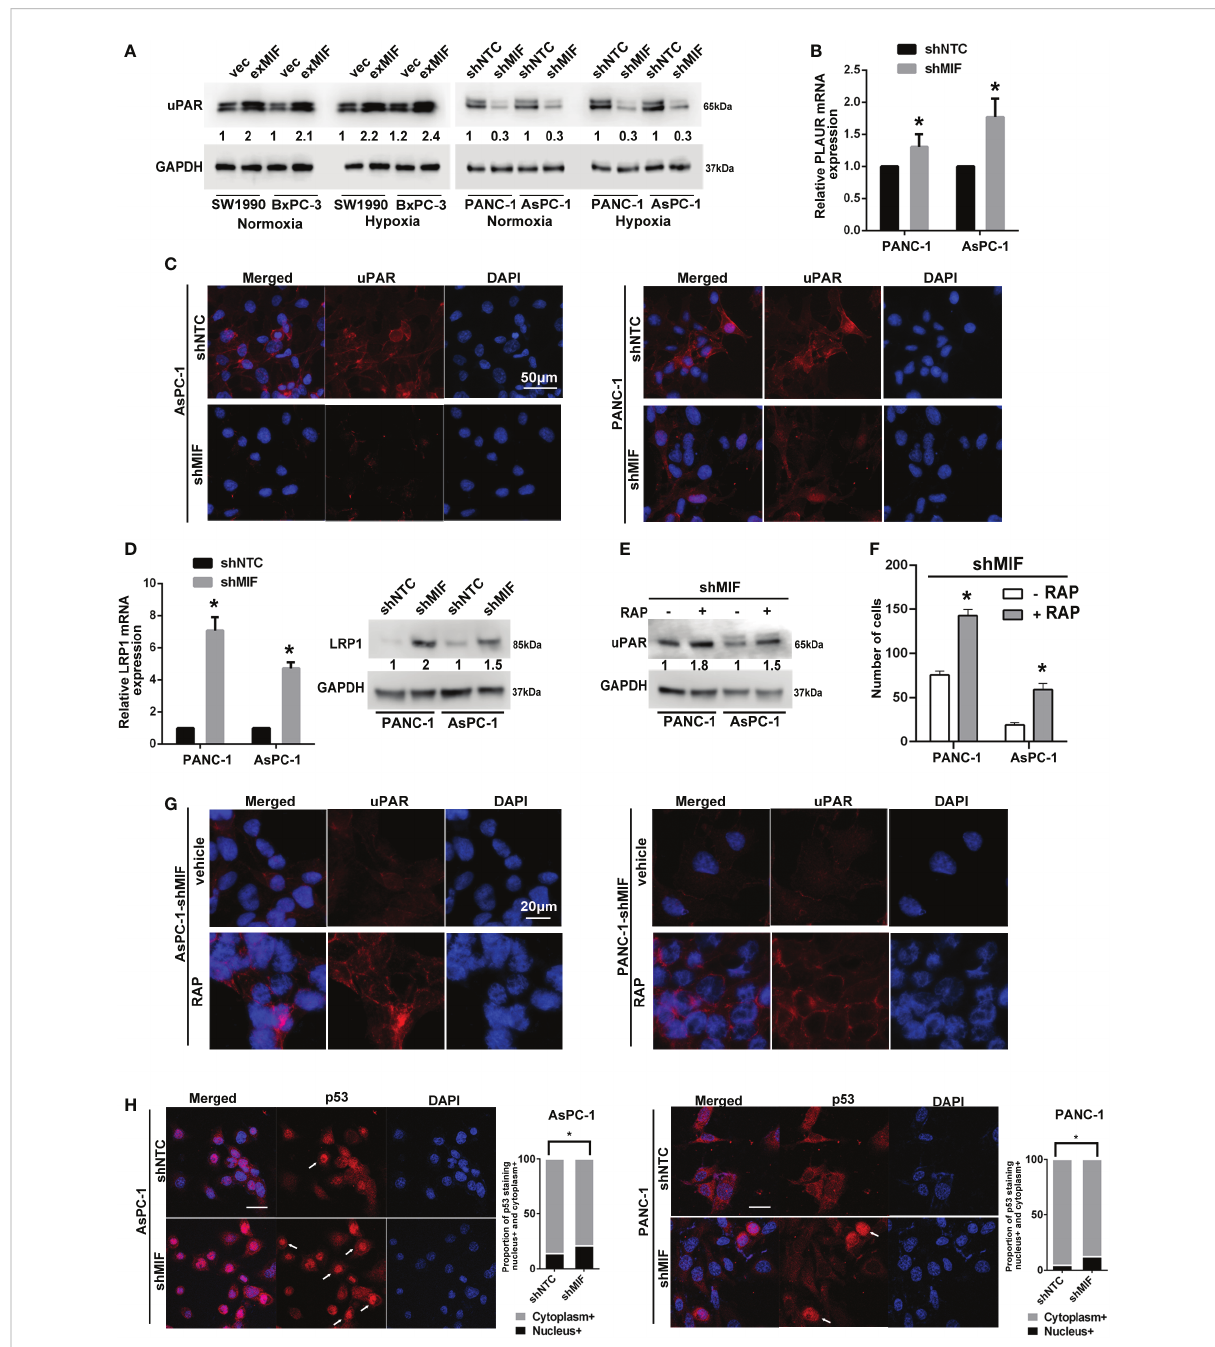
FIGURE 5 MIF enhances the expression of uPAR via LRP1 (A) Western blot analysis of uPAR in stably transduced PDAC cell lines after treatment with CoCl 2 or vehicle for 24 h. The numbers below the blots are quantitative ratios of the uPAR/GAPDH band densities. (B) Real-time PCR analysis using speci fi c primers for PLAUR with pancreatic cancer cell lines. (C) Confocal microscopy images of shMIF cells for uPAR expression on the cell surface and in the cytoplasm (red). Scale bars, 50 m m. (D) Real-time PCR and western blot analysis of the mRNA and protein levels of LRP1 in shMIF cells. (E) uPAR levels in shMIF cells treated with the LRP1 antagonist RAP or vehicle. (F) Quanti fi cation of invasion assays of shMIF cells treated with LRP1 antagonist, RAP or vehicle using Matrigel matrix-coated transwell chambers. (G) Immuno fl uorescence images of uPAR on the cell surface and in the cytoplasm with the addition of RAP or vehicle in shMIF cells. (H) Immuno fl uorescence images and quanti fi cation of nuclear/cytoplasmic p53 staining in AsPC-1 and PANC-1 cells. The graphs show the mean of the proportions of p53-positive staining in the nucleus versus the cytoplasm. Scale bars, 20 m m. * P <